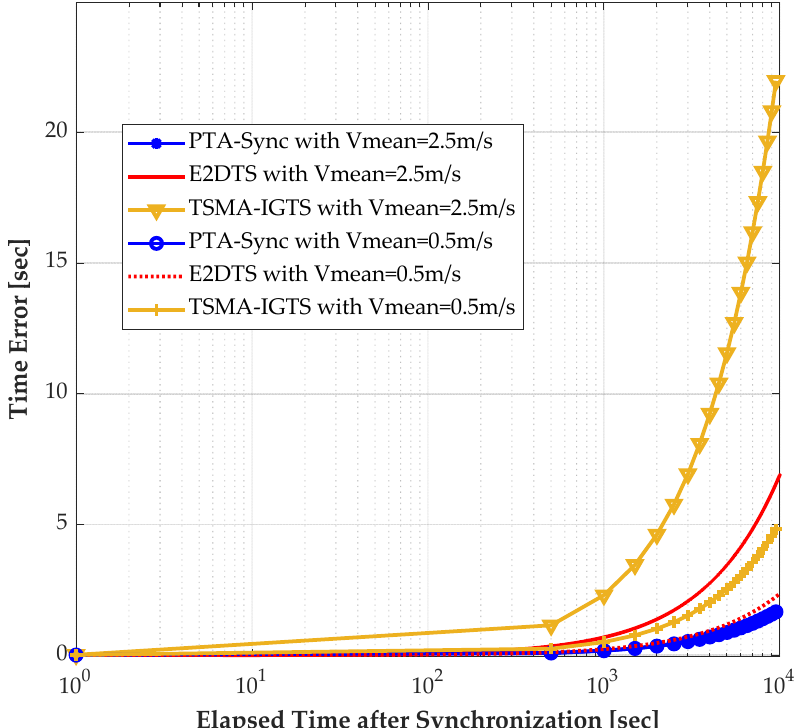
Figure 3. Time error measured at 30 s after synchronization versus T when V_mean = 2.5 m/s, 0.5 m/s, I_tx = 1.2 s, N_ex = 30, Nr = 15 km, α = 0.5.